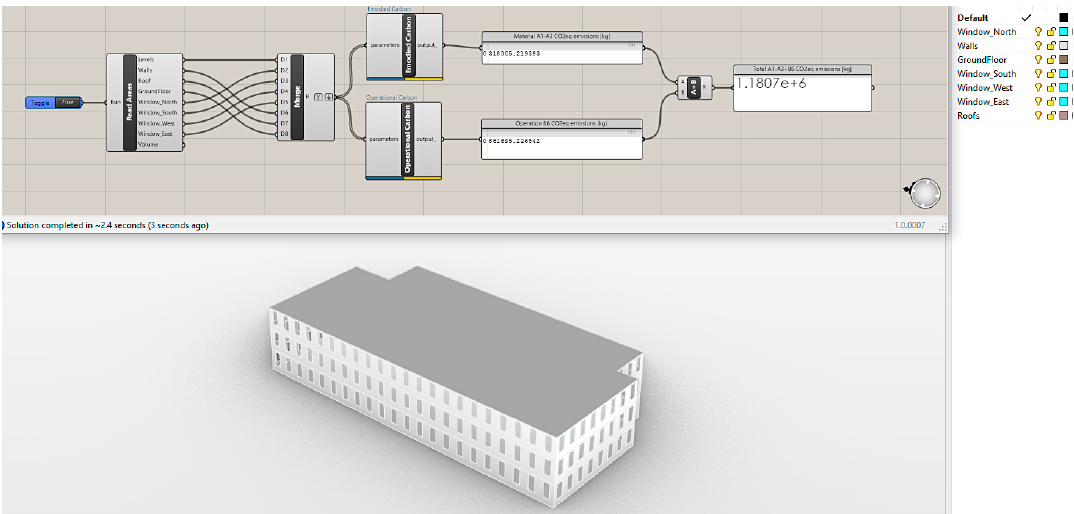
Figure 9. Using the trained ML model back in Grasshopper allows for a quick estimation of the Total Carbon Footprint of a given shape. The building model has to be separated into correctly named layers that represent the building components. The user just needs to click a button and then an estimation is instantly provided.